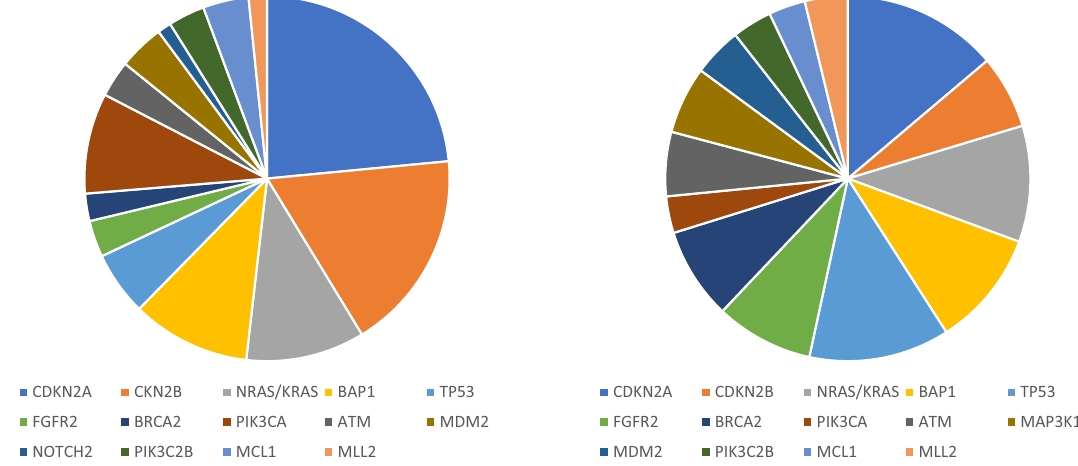
Figure 2. Mutations’ incidence in IDH1m patients and in IDH1wt patients.